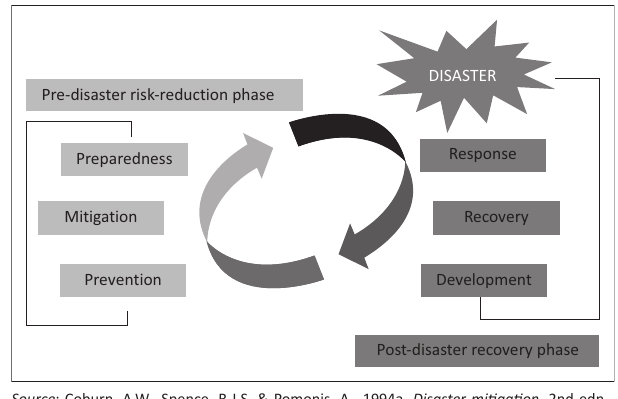
FIGURE 3: The disaster continuum